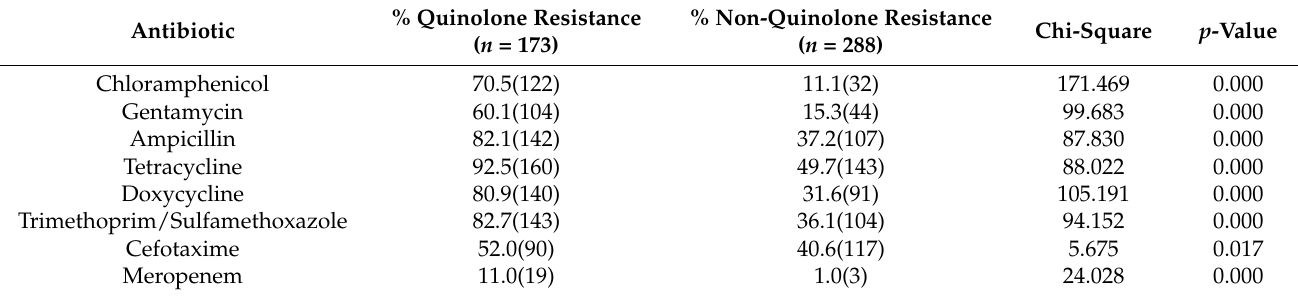
Table 7. Comparative antibiotic resistance of quinolone-resistant versus non-quinolone-resistant E. coli. Antibiotic